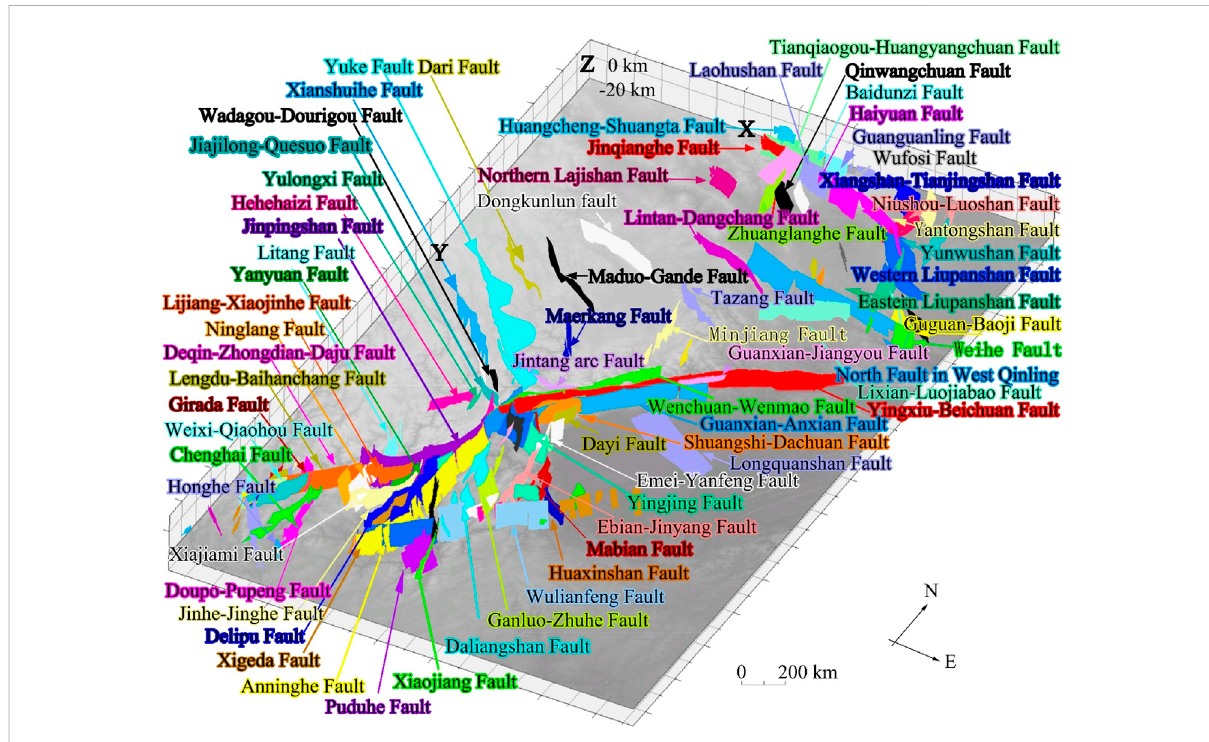
FIGURE 4 Oblique view ofthe3Dmodel of263 ruptured seismogenicfaults intheNorth – South Seismic Belt.ETOPO1 (Amante,2009)is usedas thebase map and placed at a depth of 20 km, and the vertical exaggeration is